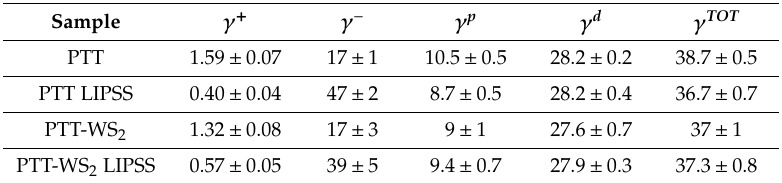
Table 4. Values of the polar positive ( γ + ), polar negative ( γ − ), dispersive ( γ d ) and total ( γ TOT ) contributions to the surface energy for non-irradiated samples and samples irradiated with 5000 pulses and a fluence of 20.3 mJ / cm 2 according to the van Oss, Chaudhury and Good’s model (mJ / m 2